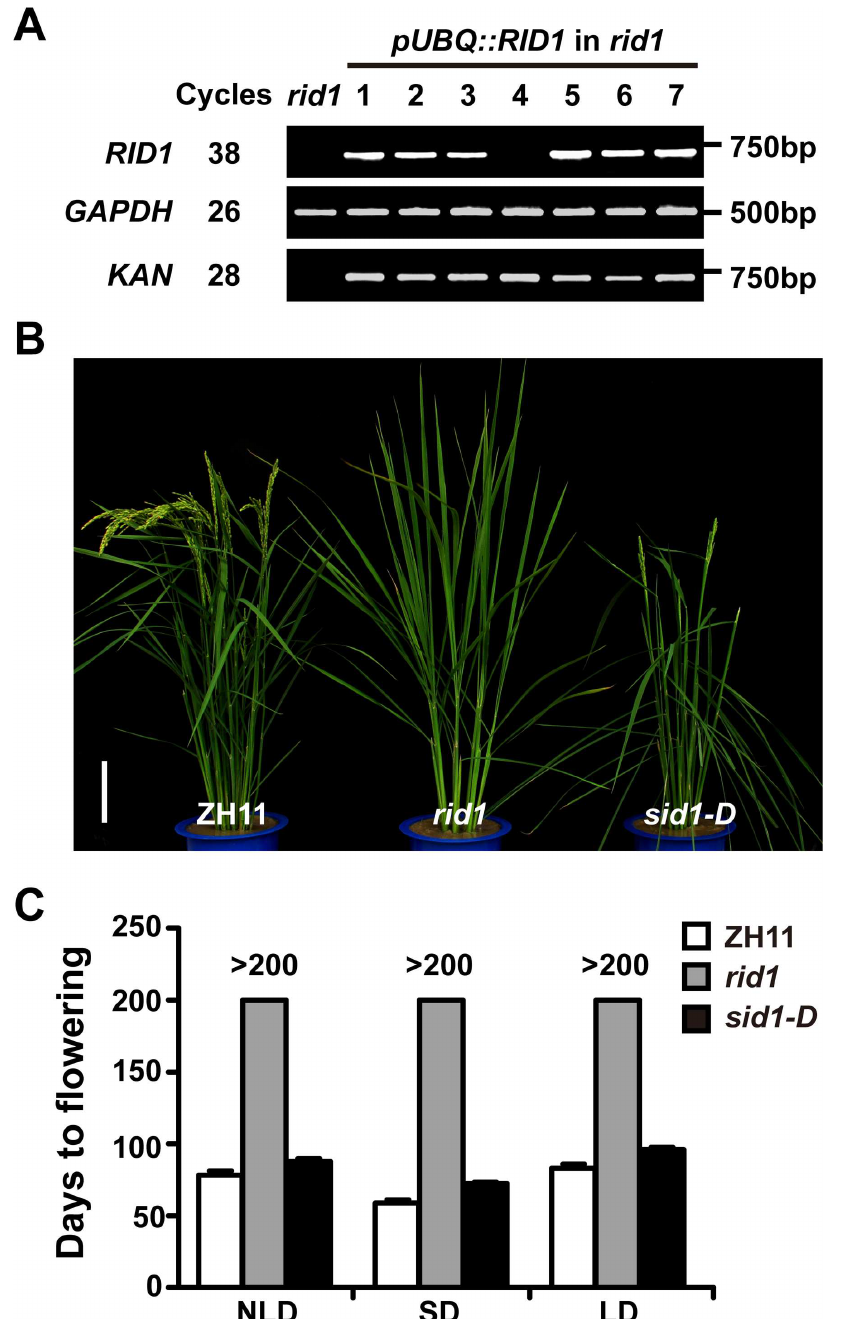
Fig 1. Characterization of sid1-D , a dominant genetic suppressor of rid1 . (A) Transcript analysesof RID1 in transgenicfloweringlines carrying pUBQ :: RID1 in rid1 background (lanes 1 to 7). Note that no transcript of RID1 was detected in line 4 (renamedas sid1-D ). rid1 served as the negative control, and GAPDH gene served as an internalcontrol. KAN amplifiedfrom Kanamycin geneindicatedthe T-DNA insertion. pUBQ , maize Ubiquitin promoter. (B) Phenotypiccomparisonof ZH11 (control), rid1 , and sid1-D plants at the headingstage. Scale bar, 15 cm. (C) Floweringtimes of ZH11, rid1 , and sid1-D under the indicatedday length conditions ( n = 10). NLD, natural-long-day; SD, short-day; LD, long-dayconditions.